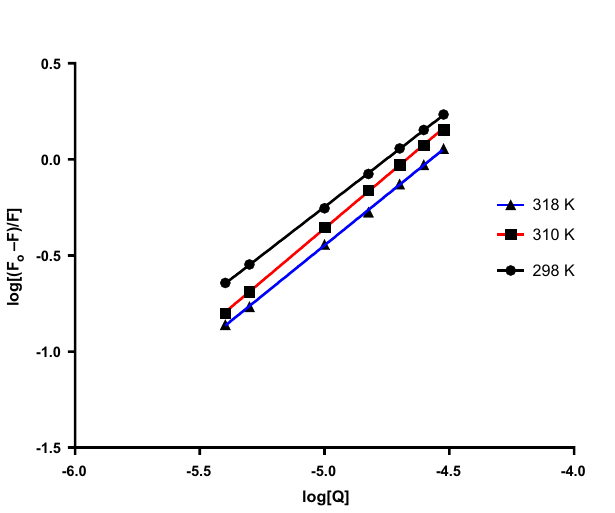
Figure 5. Plots of log (F o −F)/F versus Log [Q] at three temperature settings.